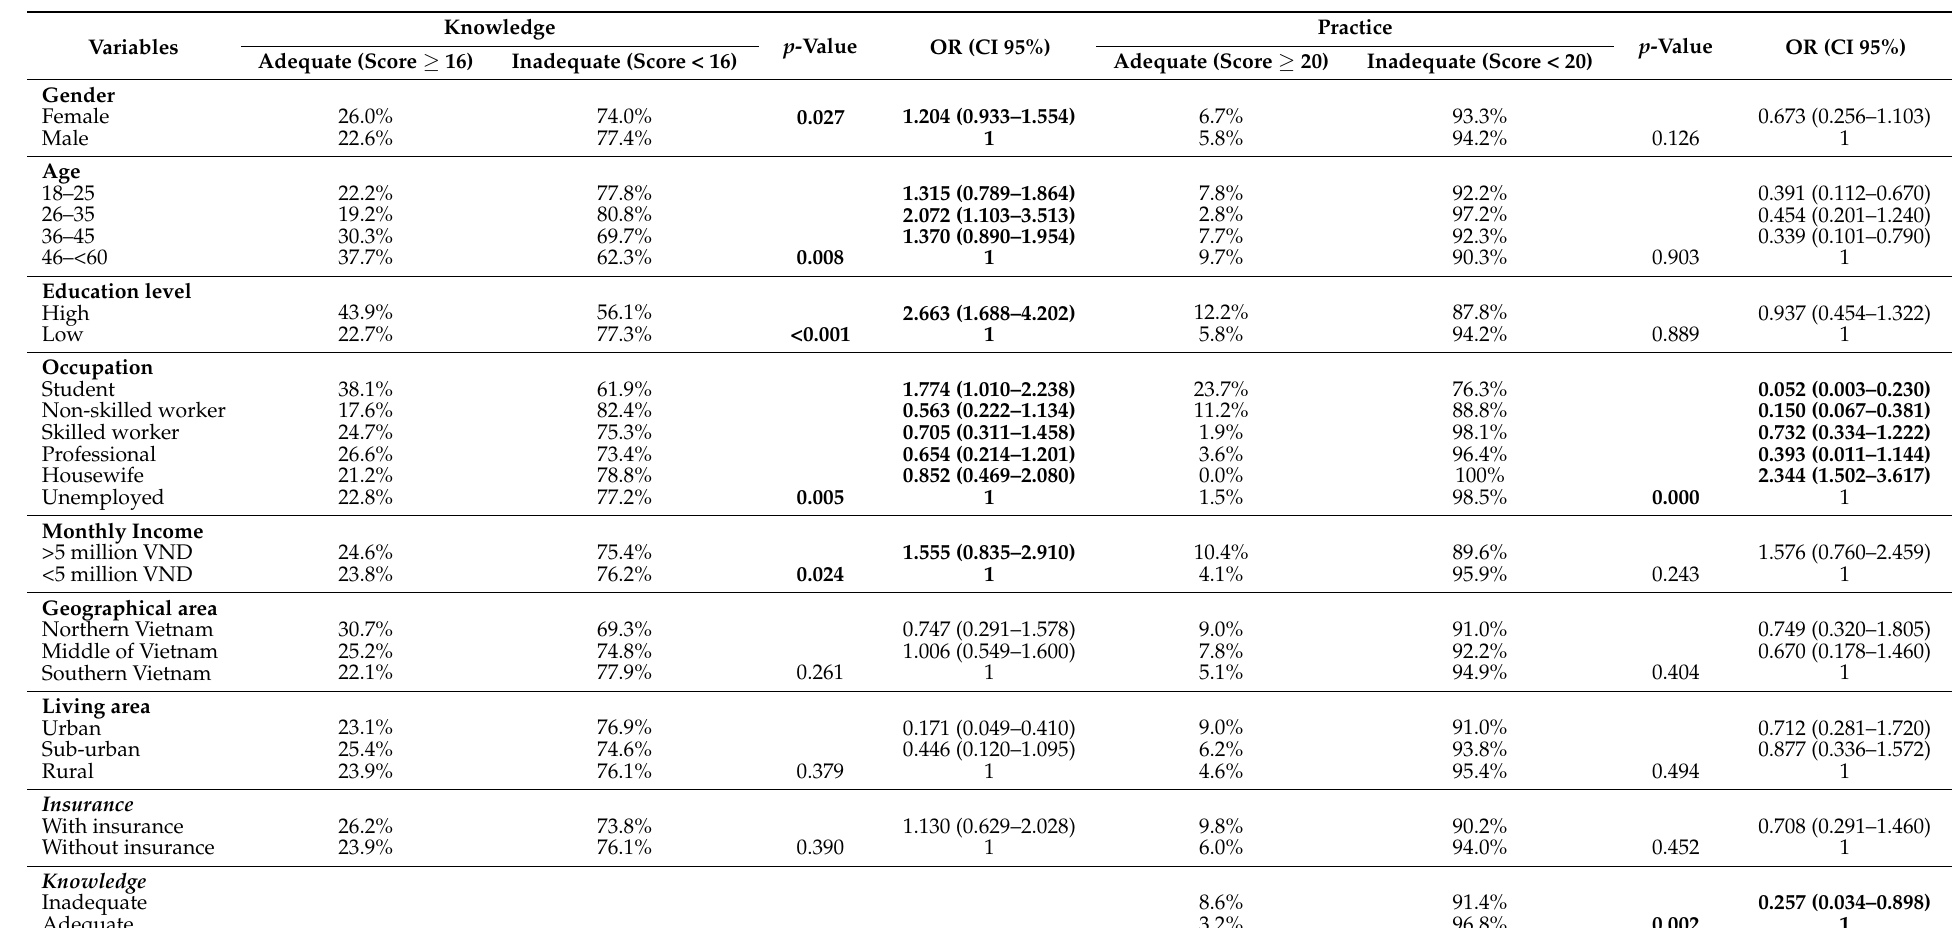
Table 2. Multivariate analysis on the associations between Vietnam public knowledge/practice and socio-demographic characteristics. OR: odds ratio; CI: confidence